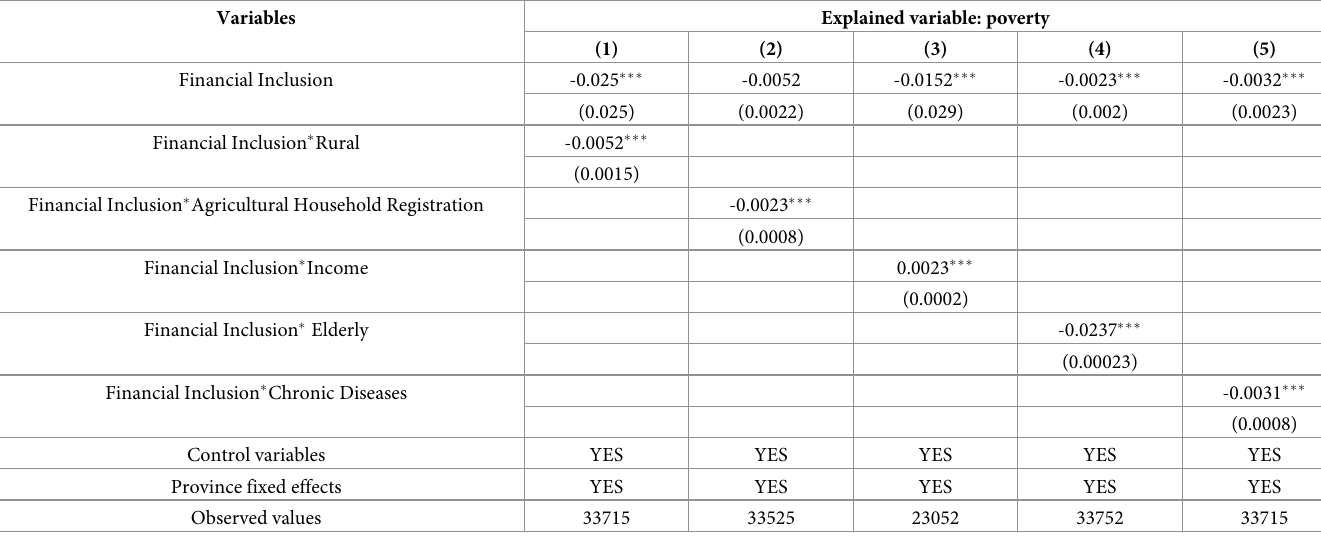
Table 6. Whether financial inclusion is a " more flowers on the brocade" or " fuel in snowy weather" (2SLS